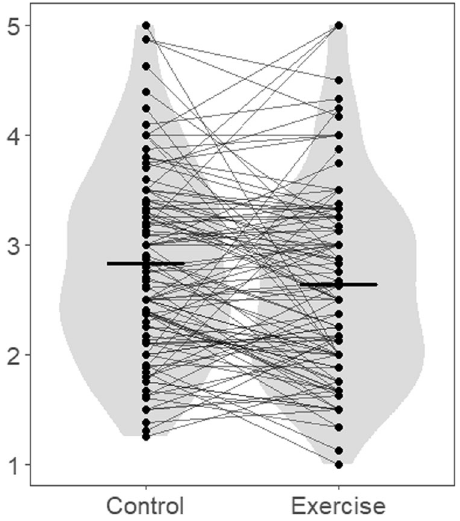
Fig. 2 Violin plot for means within individuals and means between conditions of fatigue in the exercise and control conditions. The dots represent the means within the individual, and the bars represent the means between the conditions. Table 2. Within-person-level